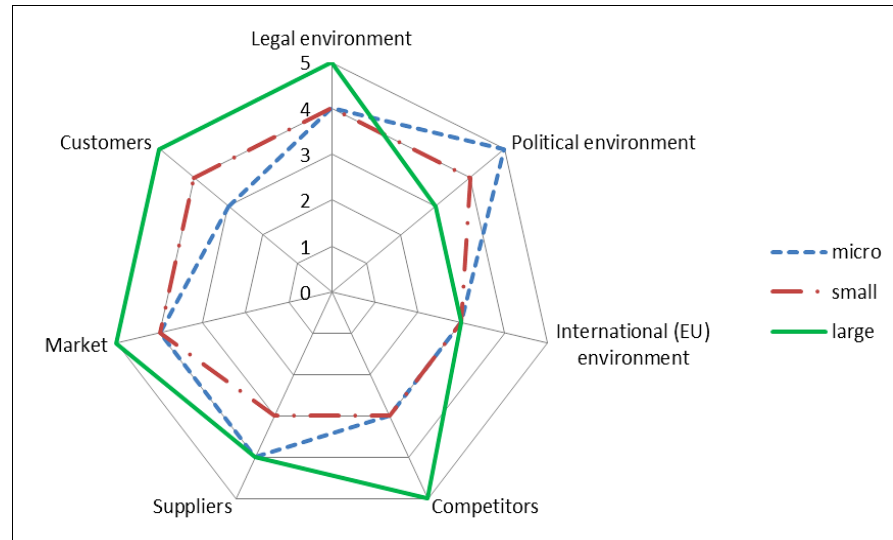
Figure 6. Elements of the environement which has influence on the companies